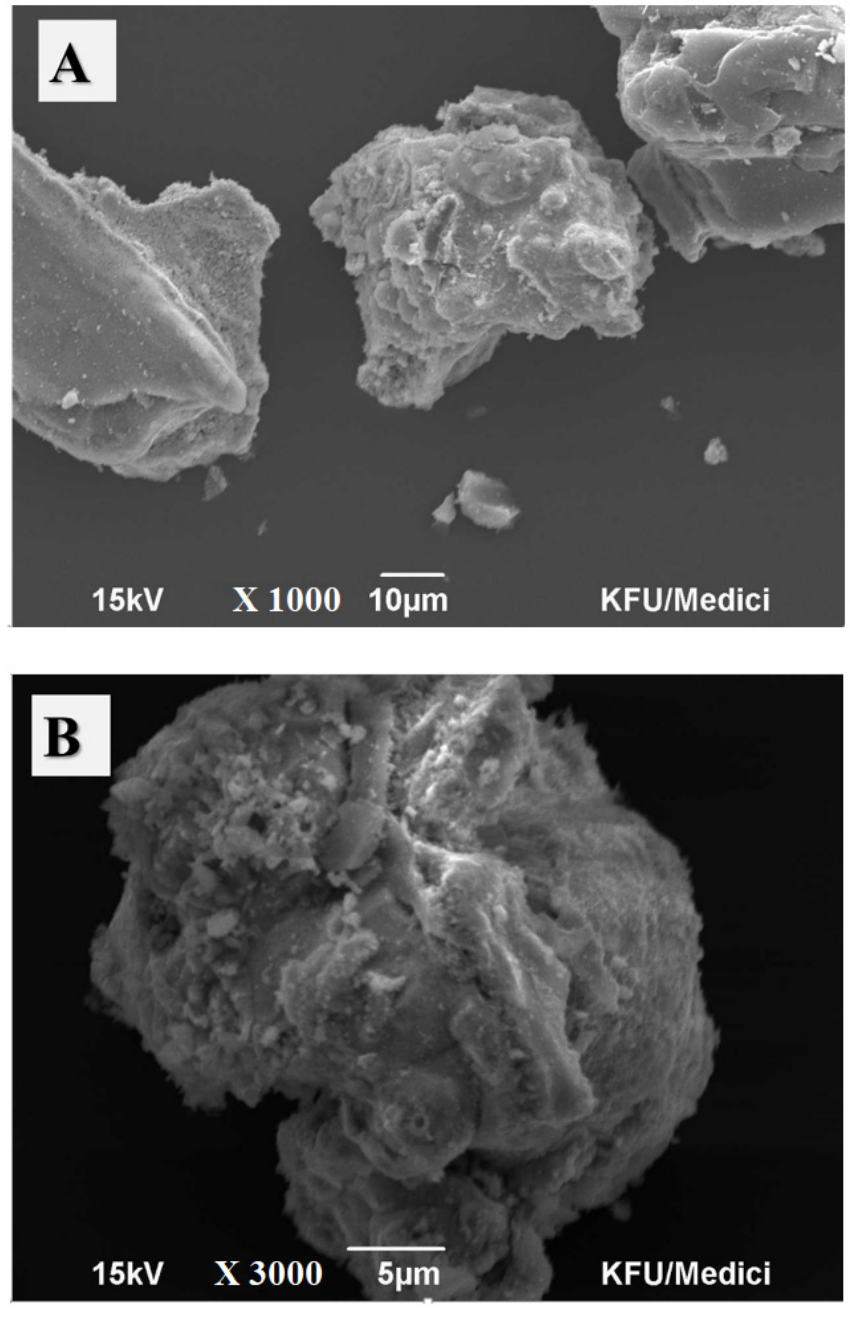
Figure 1. SEM images of the introduced Fe(0)@AC at two different magnifications; 1 KX ( A ), and 3 KX ( B ).